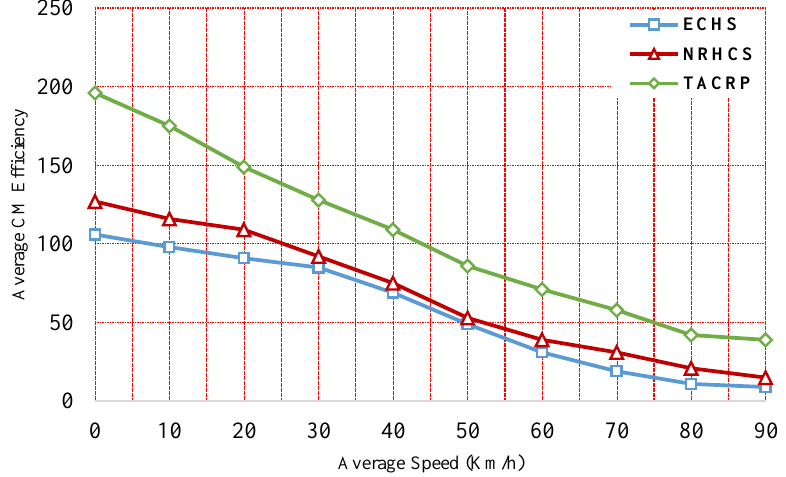
Figure 11. Average CM Efficiency Calculation.